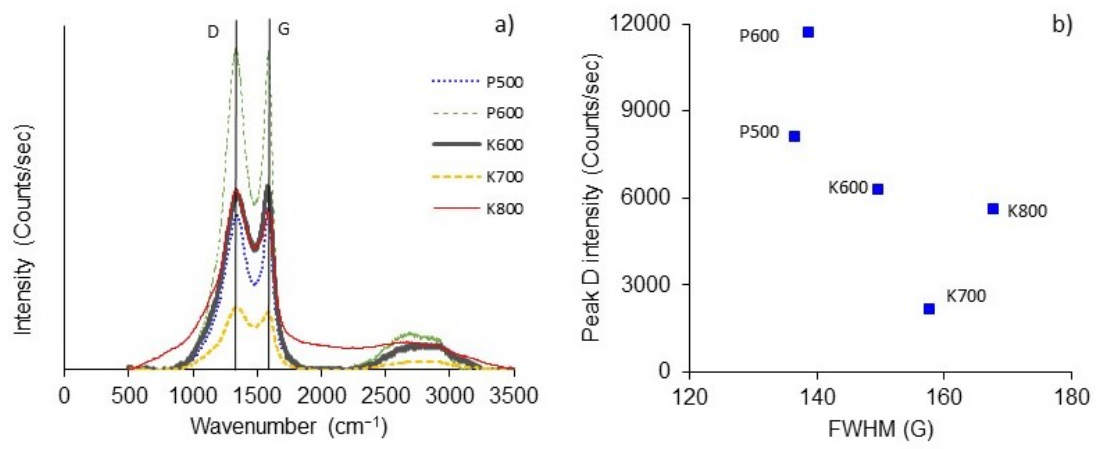
Figure 5. ( a ) Raman spectra of BNCAs, and ( b ) the intensity of I D as a function of the FWHM of I G . D-peak: intensity (I D ); G-peak: intensity (I G Table 1. Structural properties of BNCA.